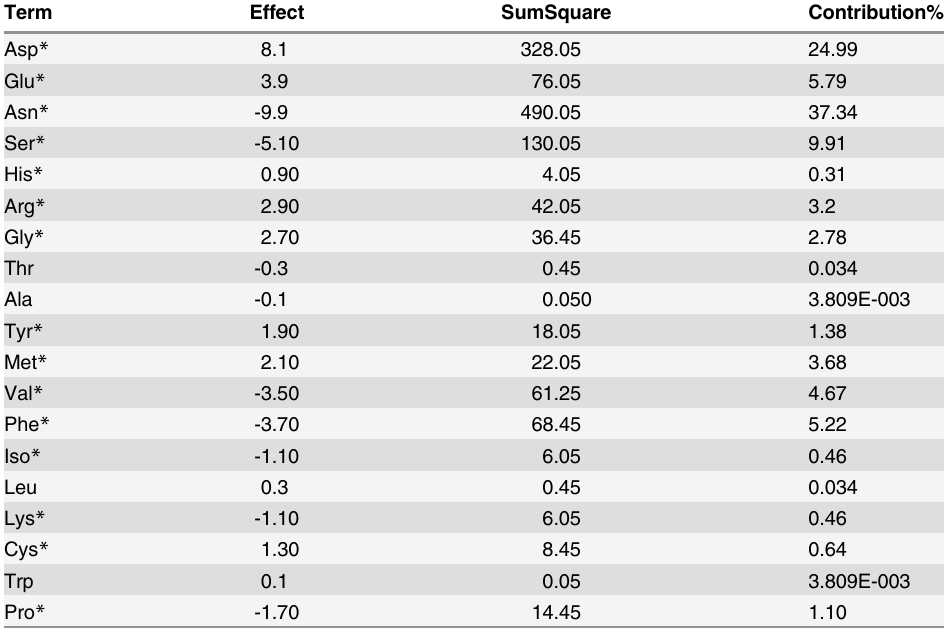
* Amino acids in bold with a contribution% greater than 0.1 were chosen for the model in ANOVA. Table 5 summarizes the ANOVA results for the amino acids which were chosen based on the contribution% for the final mAb titre. Amino acids with % of contribution higher than 0.1 were chosen for ANOVA. P value Prob > F parameter should be less than 0.05 to be strongly significant. The significance of the proposed model for the final mAb titre response was indi- cated by the F-value (349.75) and a low probability value (P-value < 0.0001). The proposed model for the final mAb titre response is expressed as an empirical first order polynomial equa- tion in terms of fifteen variables in Eq 1: